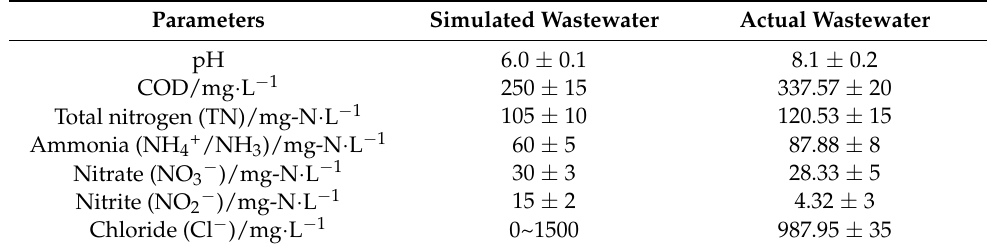
Table 1. The main characteristics of the applied